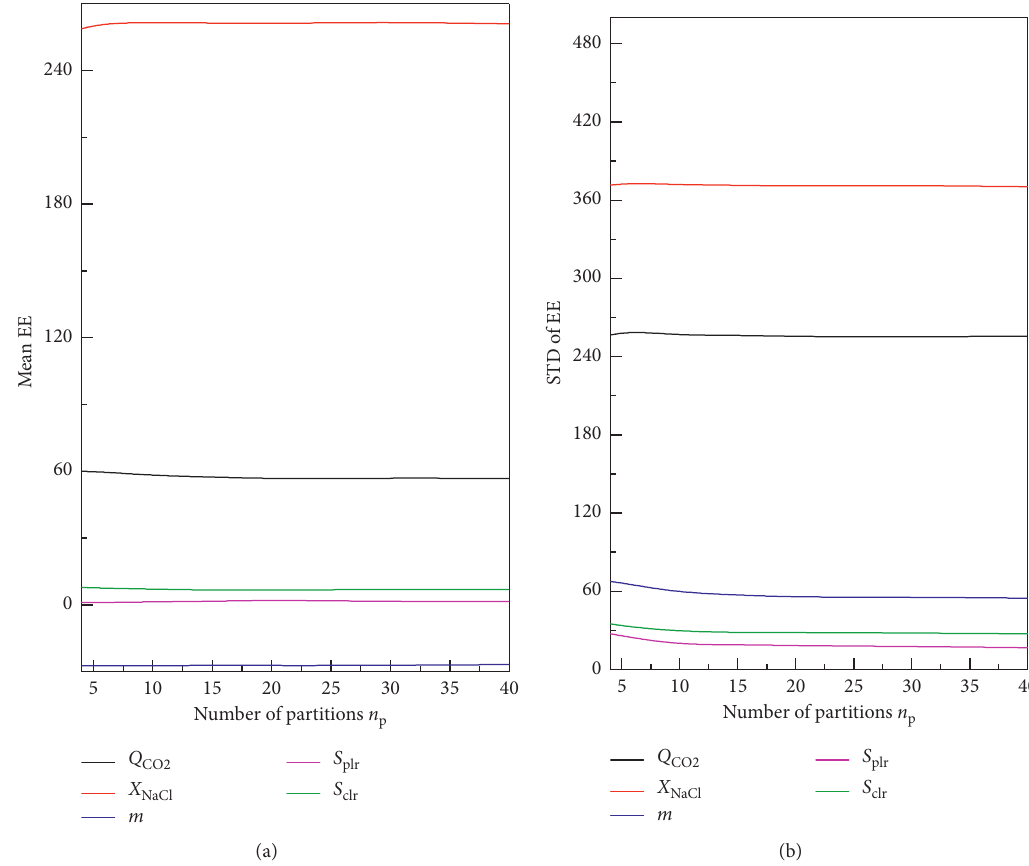
Figure 8: (a) Mean EE and (b) STD of EE as a function of partition ( n